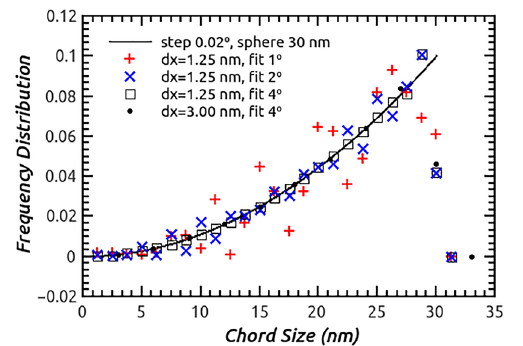
Figure 5. Theoretical chord length distribution for spherical particles with 30 nm diameter (line according to Eq. (10)) and results from fitting the corresponding theoretical peak profile at 30 o , calculated with 0.02 o step, with different ranges and two minimum